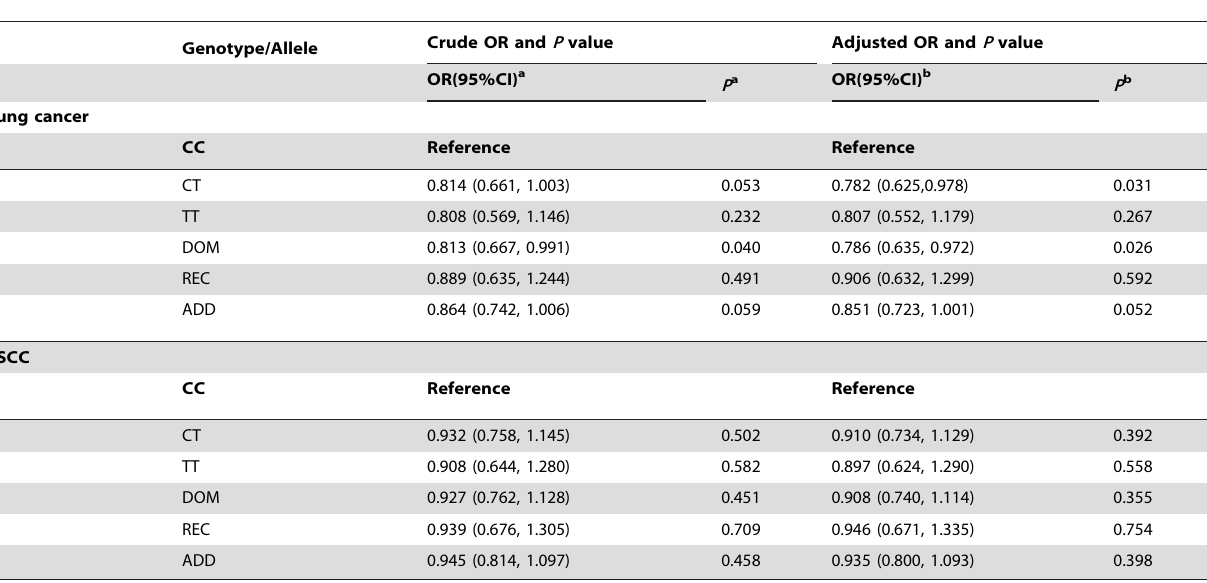
Figure 1. Forest plot of lung cancer risk associated with the rs401681 polymorphism. Stratification analysis by histology type revealed that rs401681 T genotypes were associated with a significantly reduced risk of both adenocarcinoma and squamous cell carcinoma. doi:10.1371/journal.pone.0084277.g001 adjustment for age, sex and smoking and drinking status in a multivariate logistic regression analysis, no significant association Table 3. Association between the rs401681 polymorphism and the susceptibility to lung cancer and esophageal squamous cell carcinoma